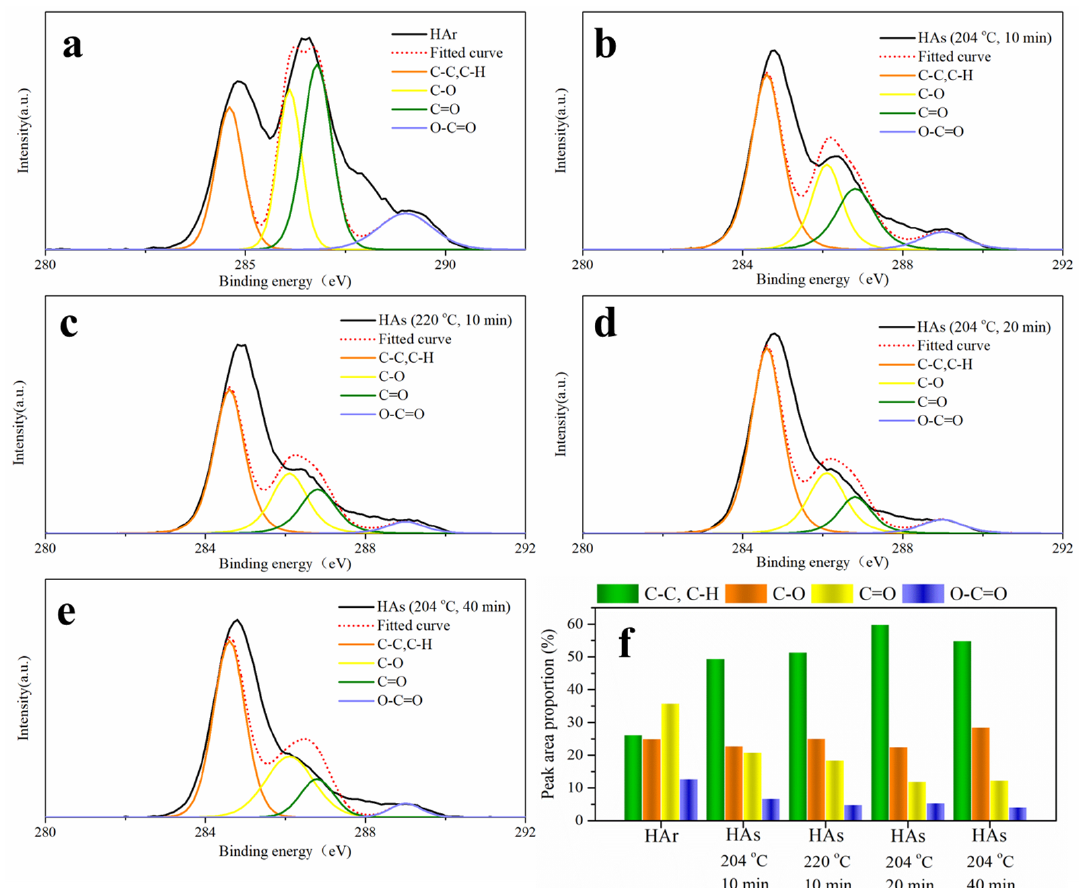
Figure 4. XPS carbon 1s spectra for HAs isolated from raw broccoli and SE broccoli (( a ): raw sample; ( b ): 204 °C 10 min; ( c ): 220 °C 10 min; ( d ): 204 °C 20 min; ( e ): 204 °C 40 min) and peak area proportion of carbon 1s spectra for HAs ( f ).